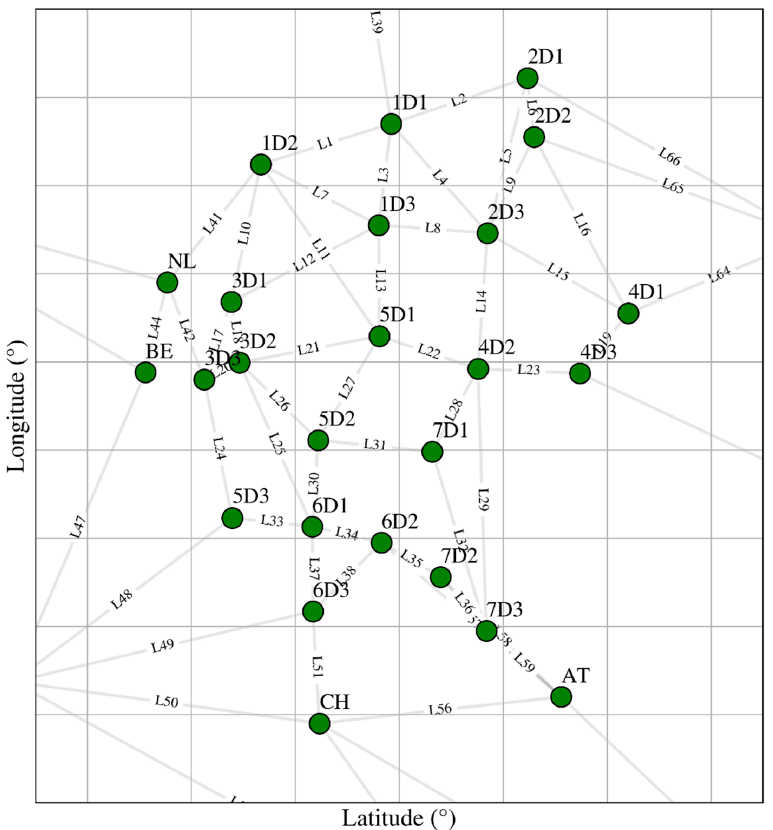
Figure 9. Topology of the generic transmission system model .